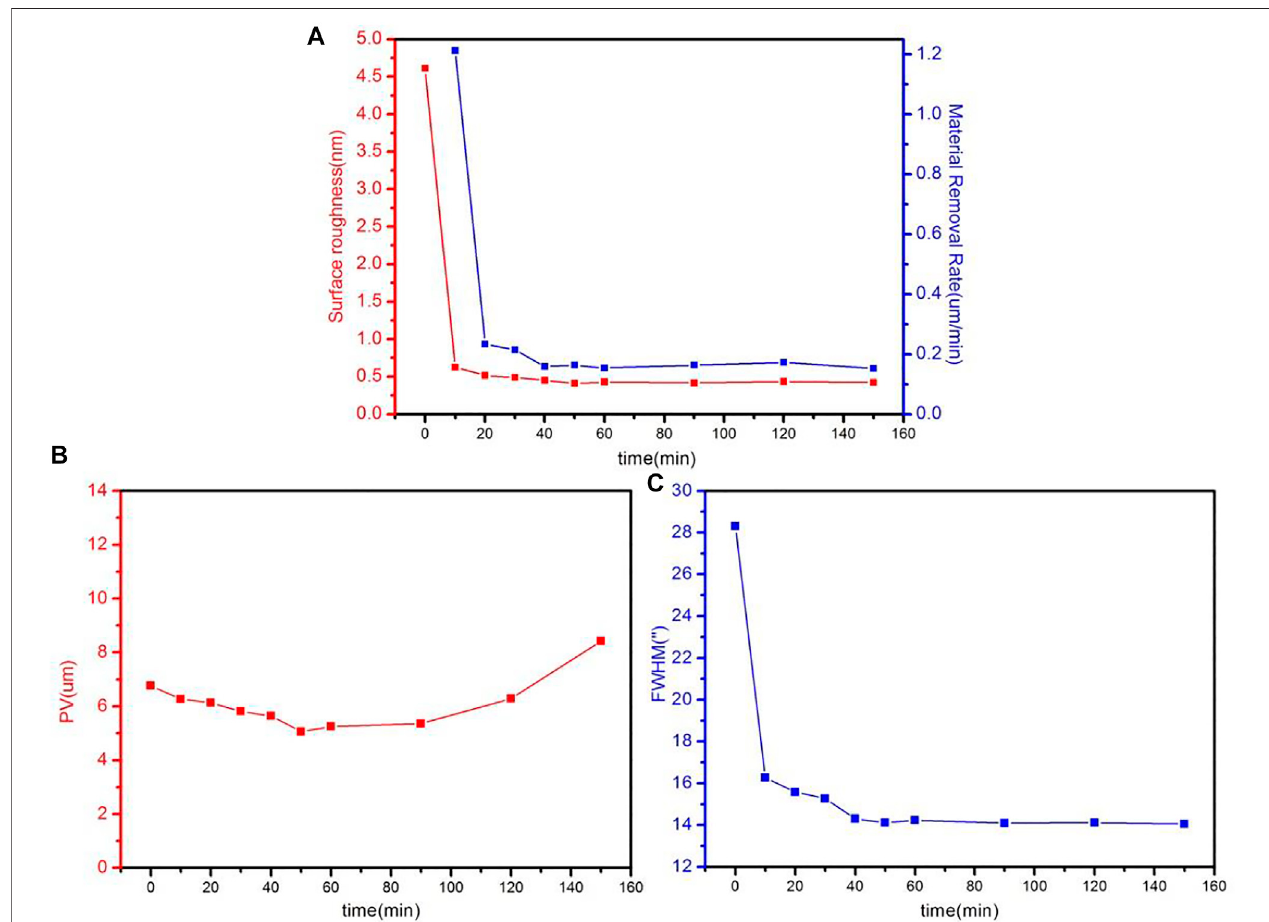
FIGURE 6 | RMS roughness, MRR, PV and FWHM of GaSb wafers as a function of the polishing time.